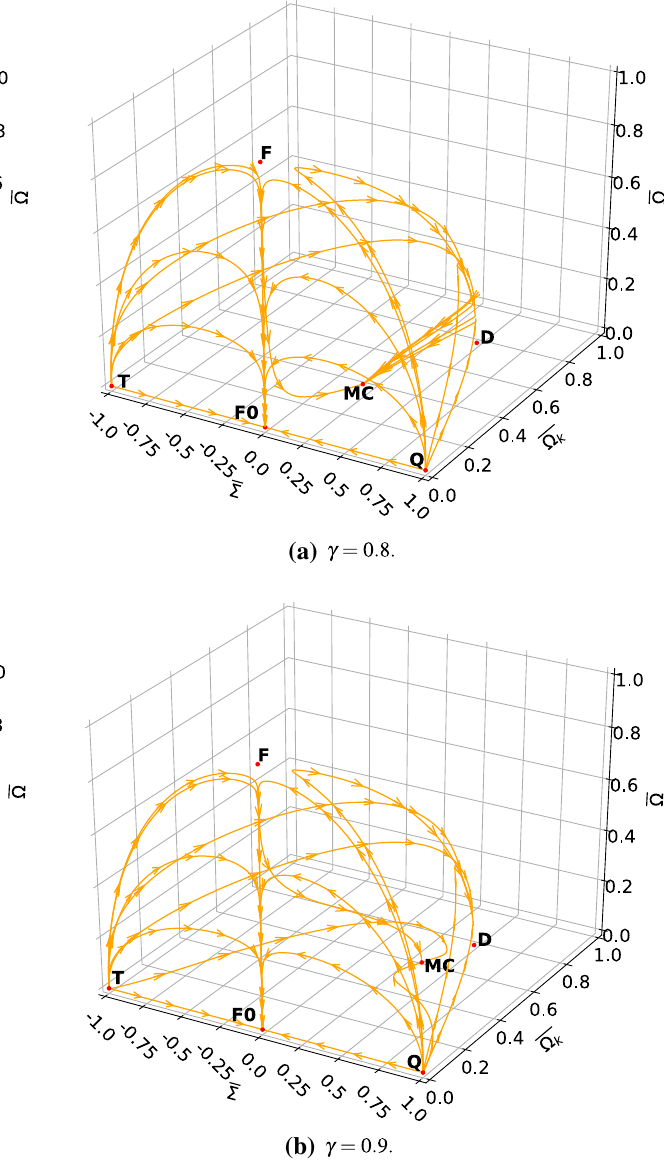
Fig. 3 Phase space of the guiding system (78a), (78b), (78c) for some values of γ = 0 . 8 , 0 . 9